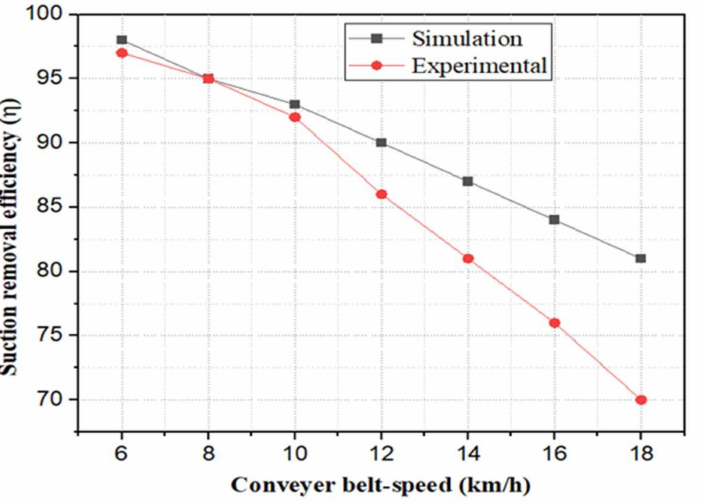
Figure 6. Comparison of suction removal efficiency between the experiment and